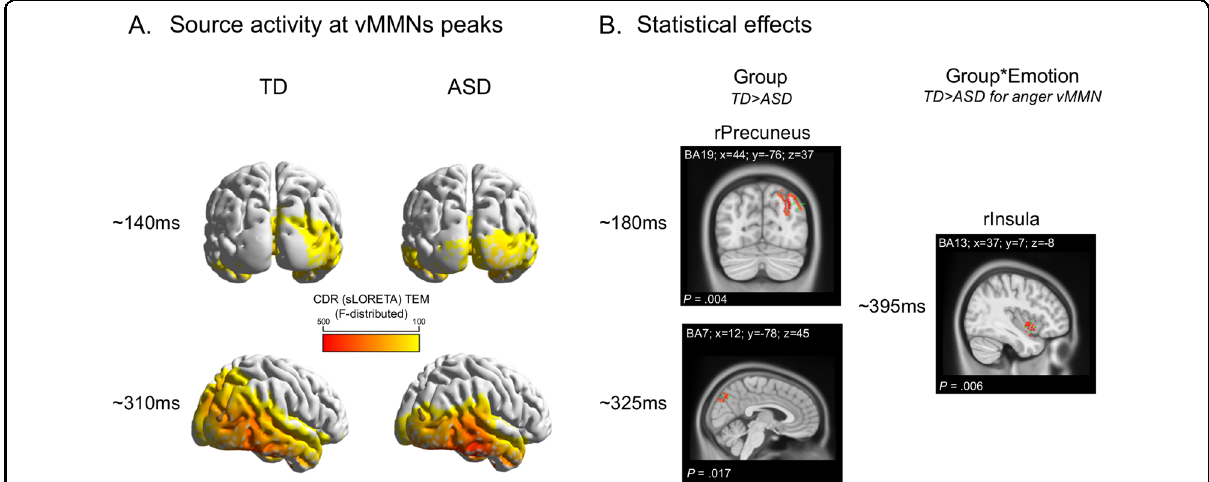
Fig. 4 vMMN source activity and group comparison. A Source activity for the TD and ASD groups (left and right sides, respectively) around the vMMN peaks (i.e., ~140 ms on the top and ~310 ms on the bottom). B Signi fi cant statistical effects: on the left side, the group effect in the right precuneus (rPrecuneus) at two latencies (~180ms and ~325 ms); on the right, the Group×Emotion interaction, due to right insula (rInsula) being stronger activated in the TD group compared to the ASD group for only the emotional deviancy (i.e., anger_vMMN at ~395